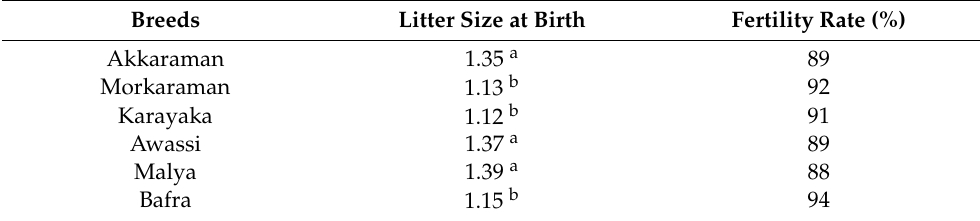
Table 1. The reproductive traits of sheep breeds. Breeds Litter Size at Birth Fertility Rate (%) Akkaraman 1.35 a 89 Morkaraman 1.13